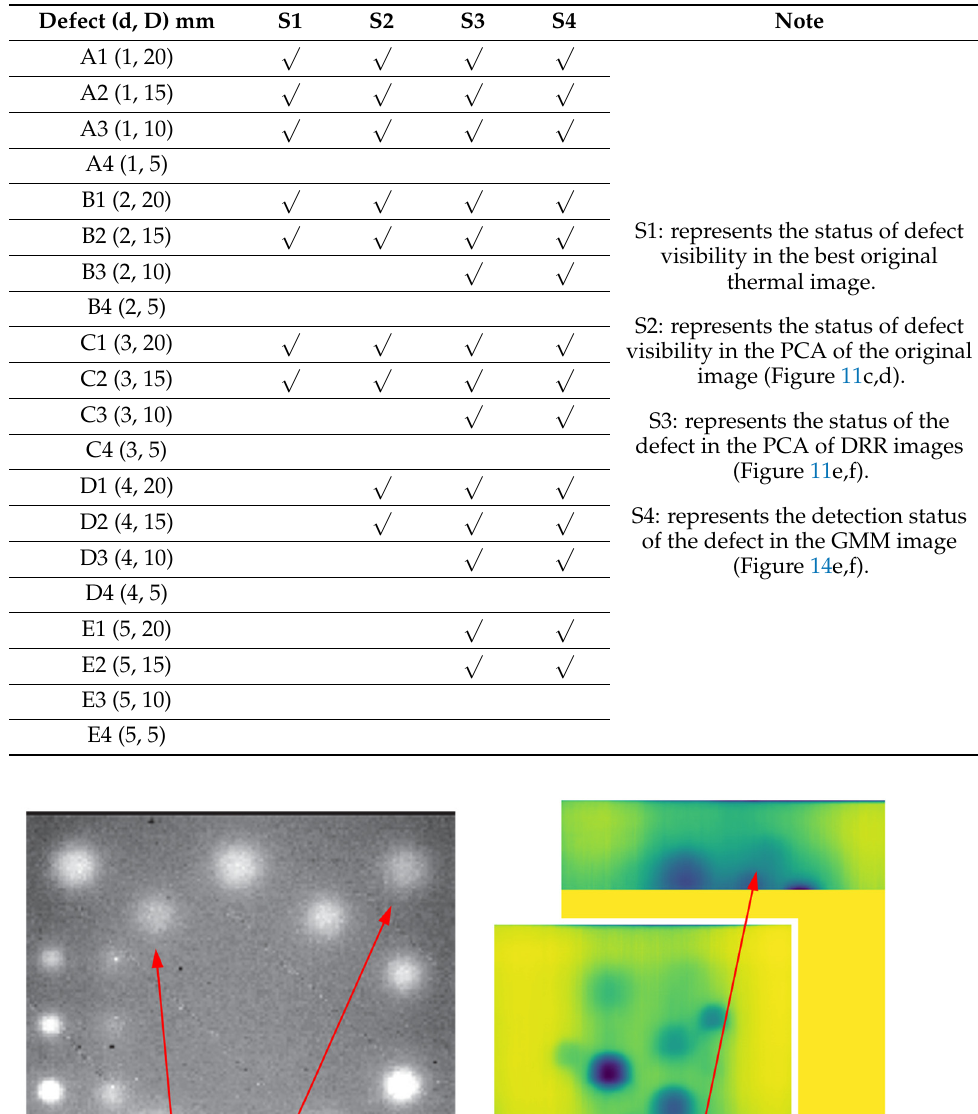
Table 3. The comparison of defect original and improved visibility and detection status.